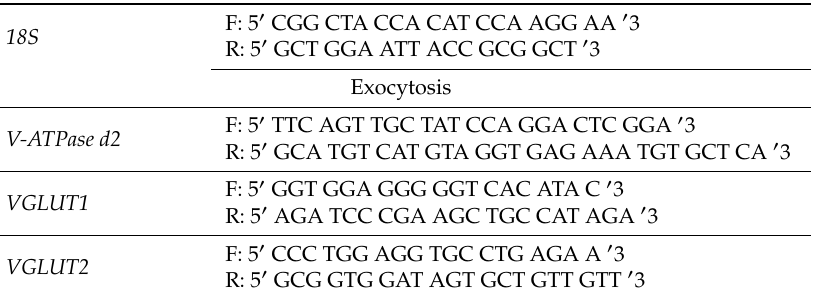
Table 1. Primer sequences used for